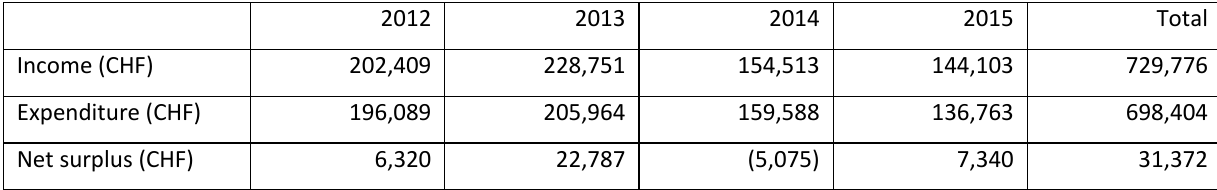
Table 1: ISPRS income and expenditure, 2012 to